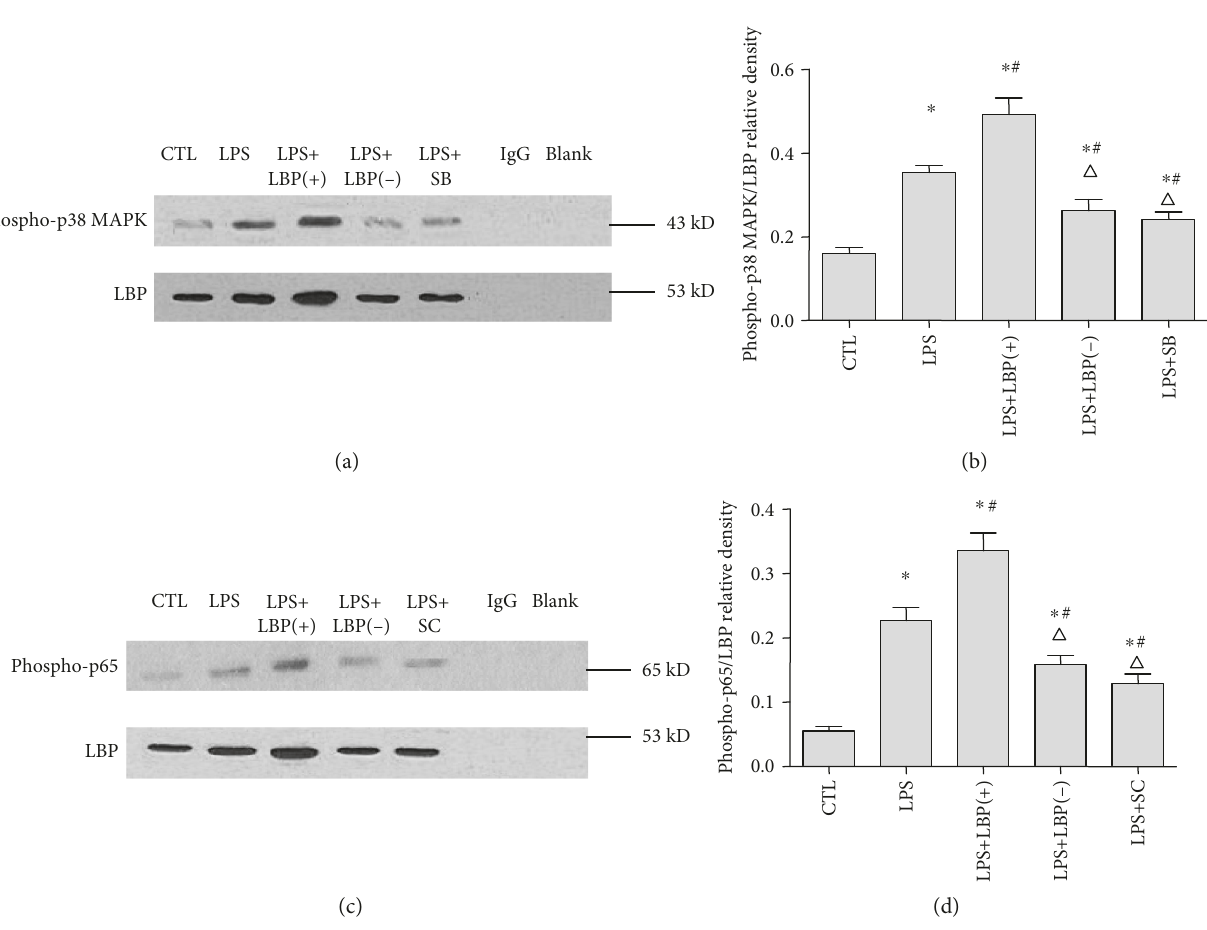
Figure 4: LBP gene overexpression enhanced the interaction between LBP and phospho-p38 MAPK and LBP and phospho-p65. LBP gene silencing inhibited the interaction between LBP and phospho-p38 MAPK and LBP and phospho-p65. SB203580 and SC-514 inhibited the interaction between LBP and phospho-p38 MAPK and LBP and phospho-p65, respectively, in A549 cells. Coimmunoprecipitation and western blotting were used to detect the interaction between LBP and phospho-p38 MAPK and LBP and phospho-p65. Phospho-p38 MAPK/LBP and phospho-p65/LBP relative densities were calculated to measure the strength of protein interactions. The result shows that LBP interacted with phospho-p38 MAPK and phospho-p65 weakly in the control group of cells ( p < 0 05 in all cases). The interaction e ff ects were strengthened by LPS stimulation. Transfection with LBP plasmid DNA and LBP shRNA-expressing plasmid DNA, respectively, strengthen and weaken the stimulatory e ff ect of LPS ( p < 0 05 in all cases). SB203580 inhibited the interaction between LBP and phospho-p38 MAPK; SC-514 also inhibited the interaction between LBP and phospho-p65 ( p < 0 05 in all cases). ∗ represents p < 0 05 when compared with that in the control group; # represents p < 0 05 when compared with that in the LPS group; △ represents p < 0 05 when compared with that in the LPS+LBP(+). Data are presented as means ± SD of six independent experiments ( n = 6